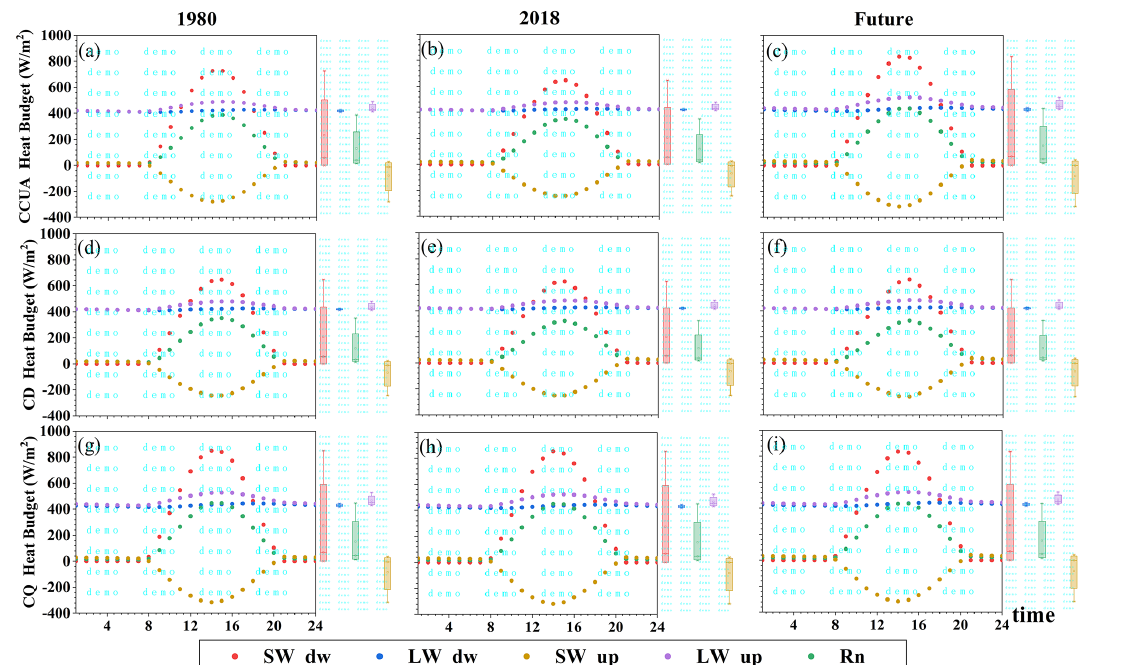
Figure 11. The diurnal variations in the changes in surface energy budget over the land use grids of 1980, 2018 and future runs of the Chengdu–Chongqing urban agglomeration: (a) 1980, (b) 2018 and (c) future. The diurnal variations in the changes in surface energy budget over the land use grids of 1980, 2018 and future runs of Chengdu: (d) 1980, (e) 2018 and (f) future. The diurnal variations in the changes in surface energy budget over the land use grids of 1980, 2018 and future runs of Chongqing: (g) 1980, (h) 2018 and (i) future.